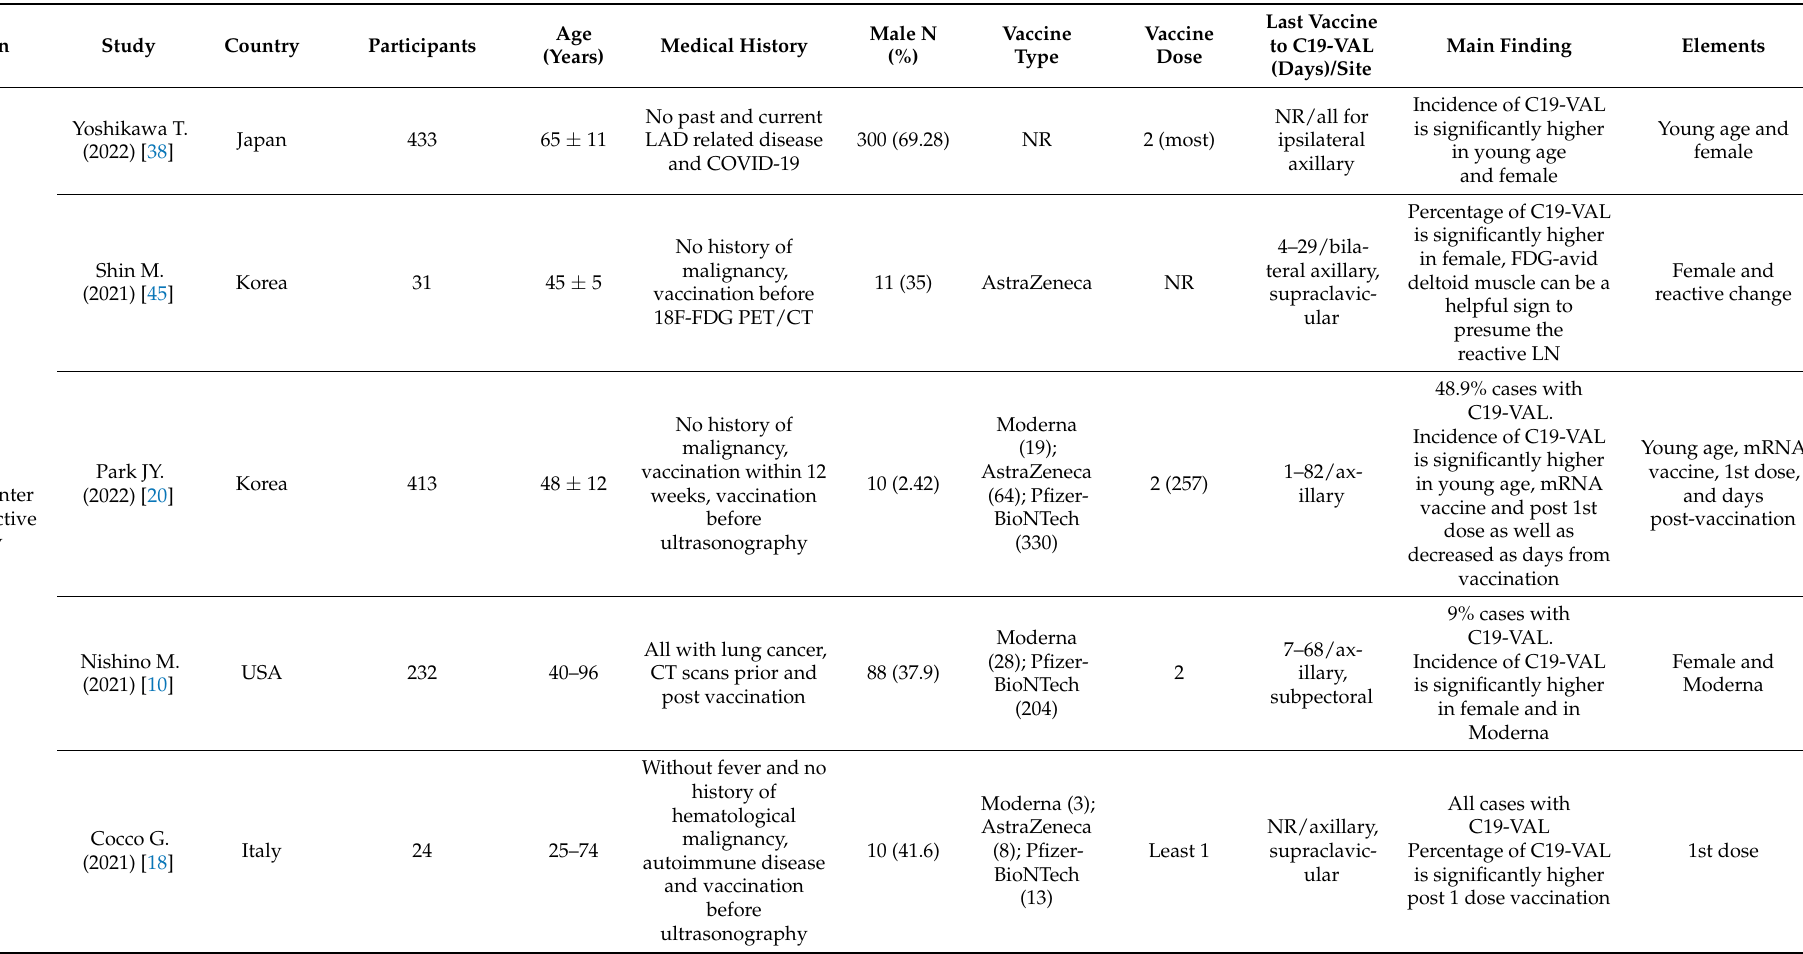
Table 1. Clinical demographics in study for associated elements in the